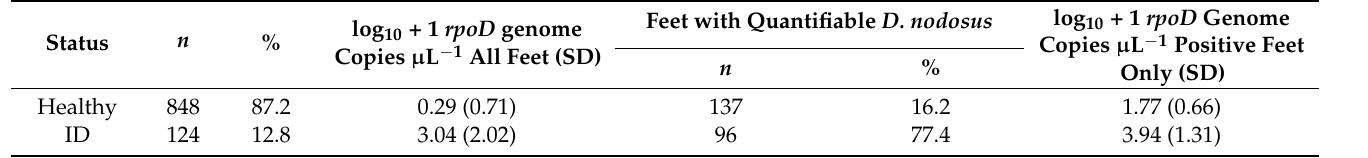
Table 7. Mean load of D. nodosus (log 10 + 1 rpoD genome copies µ L − 1 ) by clinical status of feet (all feet and feet with D. nodosus detected only) from 972 foot-level observations of 85